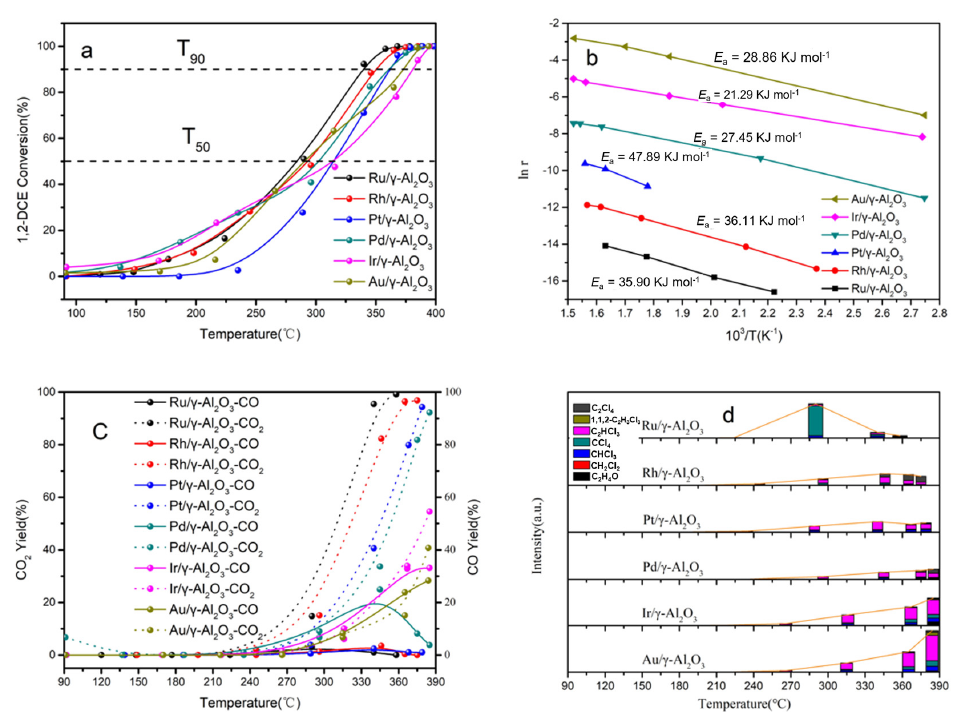
Figure 1. ( a ) 1,2-DCE conversion curves of NM/ γ -Al 2 O 3 catalysts; ( b ) Arrhenius plots of active samples for 1,2-DCE catalytic oxidation over NM/ γ -Al 2 O 3 catalysts; ( c ) CO yield and CO 2 yield over NM/ γ -Al 2 O 3 catalysts; ( d ) Distribution of by-products over NM/ γ -Al 2 O 3 catalysts during 1,2-DCE oxidation.